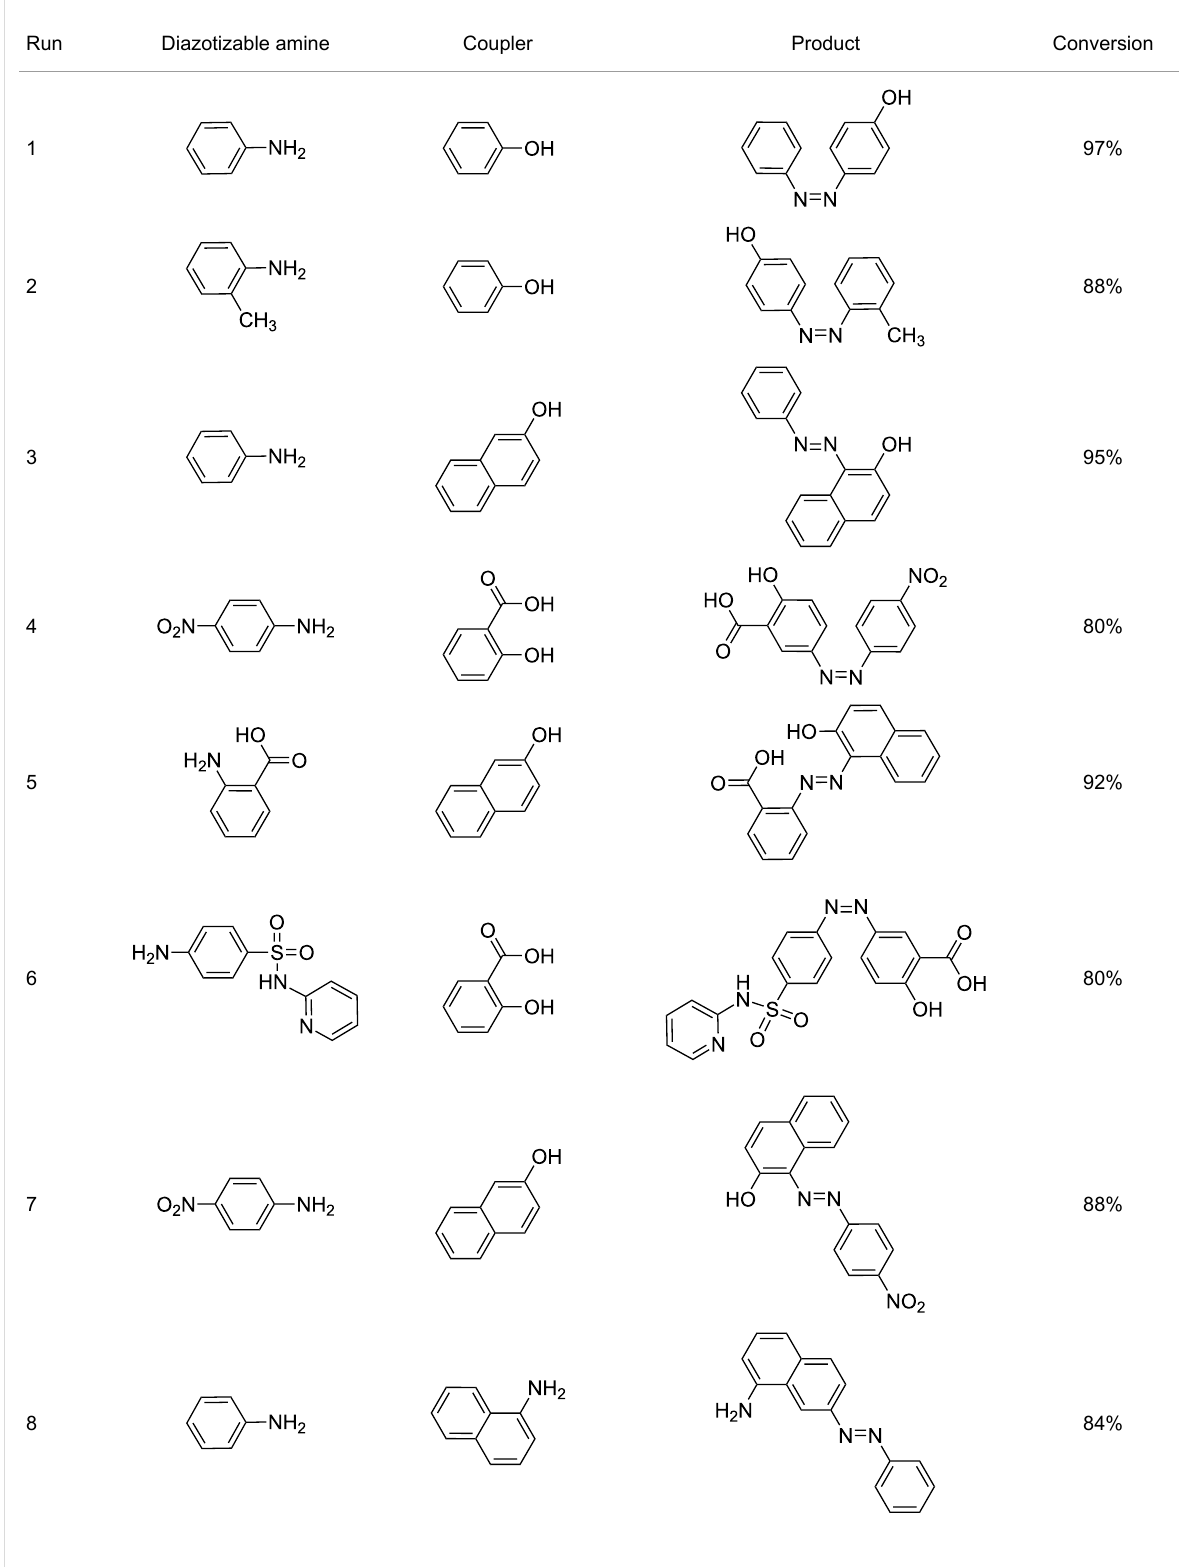
Table 7: Azo compounds synthesized under alkaline and acidic azo coupling conditions.